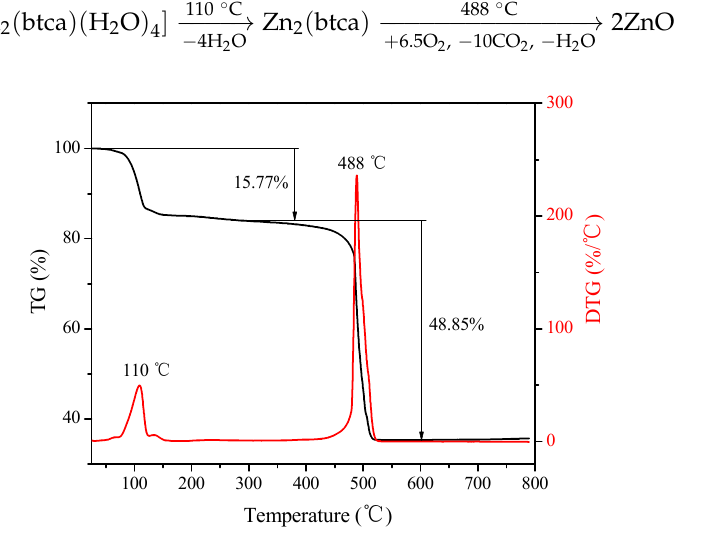
Figure 5. TG − DTG curves of [Zn 2 (btca)(H 2 O) 4 ].